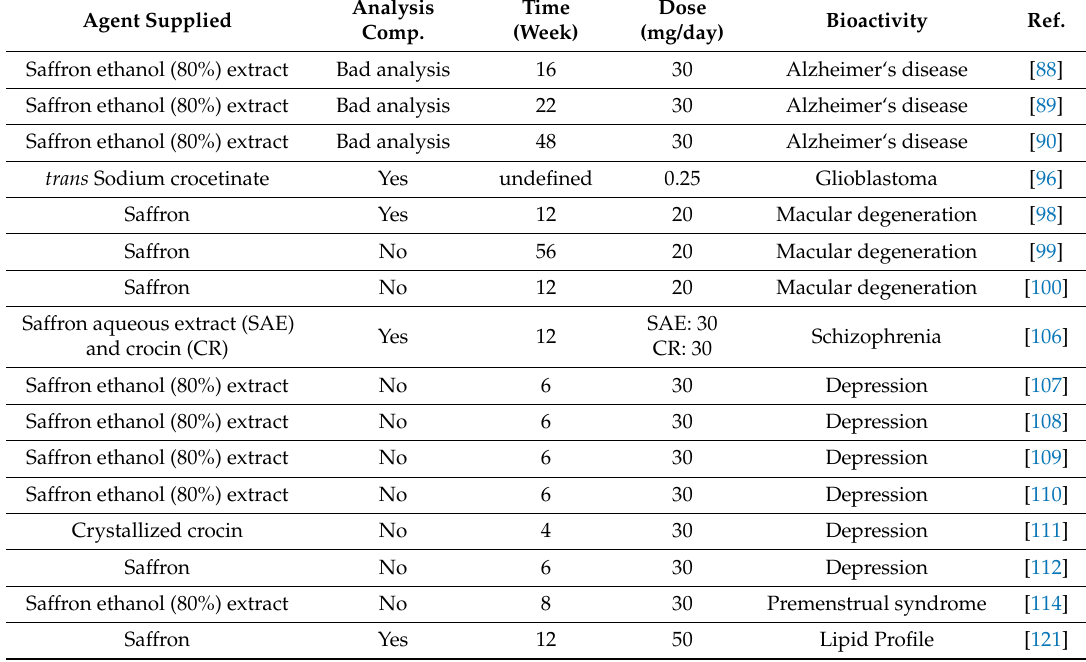
Table 1. Summary of the clinical trials found in the literature. The supplied agent is indicated, if an analysis of its composition has been carried out, time in weeks of application, dose in mg/day, demonstrated bioactivity and reference.